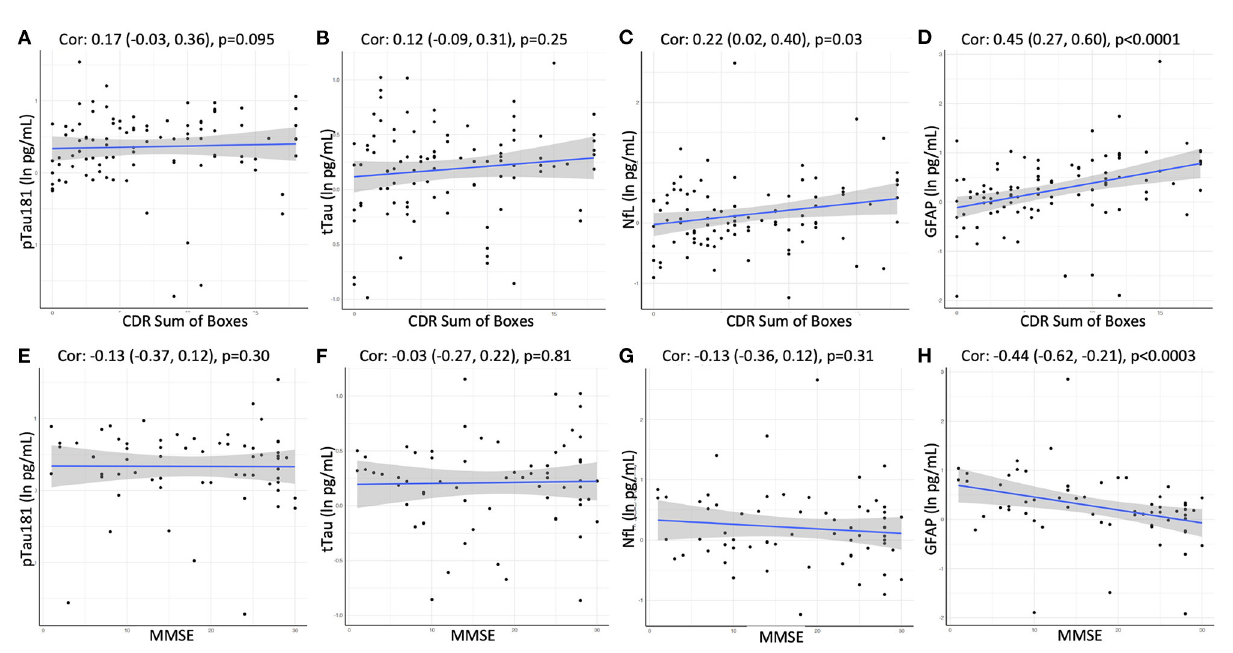
FIGURE5 Correlation between CDR Sum of Boxes or MMSE and plasma levels of (A, E) pTau181, (B, F) tTau, (C, G) NfL, and (D, H) GFAP using Spearman rank-order correlation. Spearman’s rho with 95% confidence interval and p -values are show on top of each